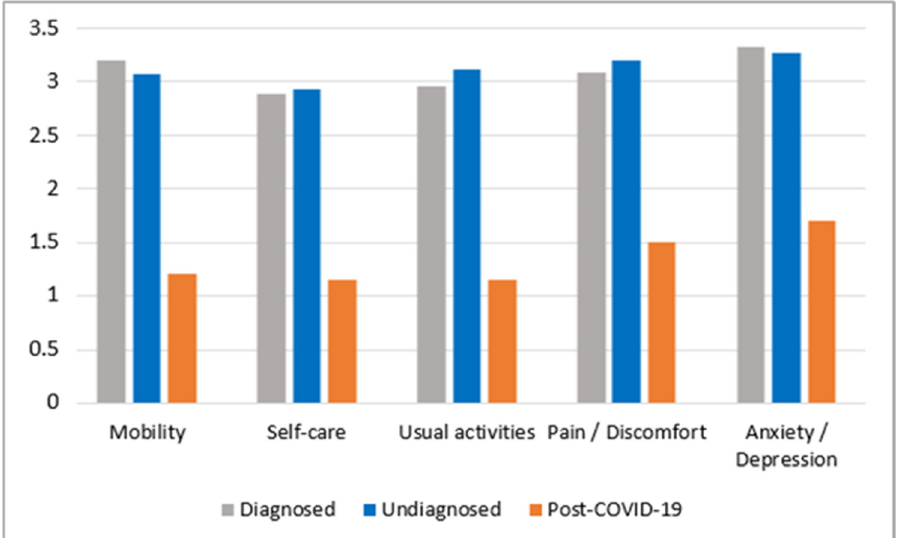
Figure 6. Patient-reported health-related quality of life, as measured by the EuroQol-5D-5L frame- work (1—the best possible option, and 5—the worst), in ME/CFS patients and undiagnosed persons prior to COVID-19, and former COVID-19 patients (6 months after being affected).